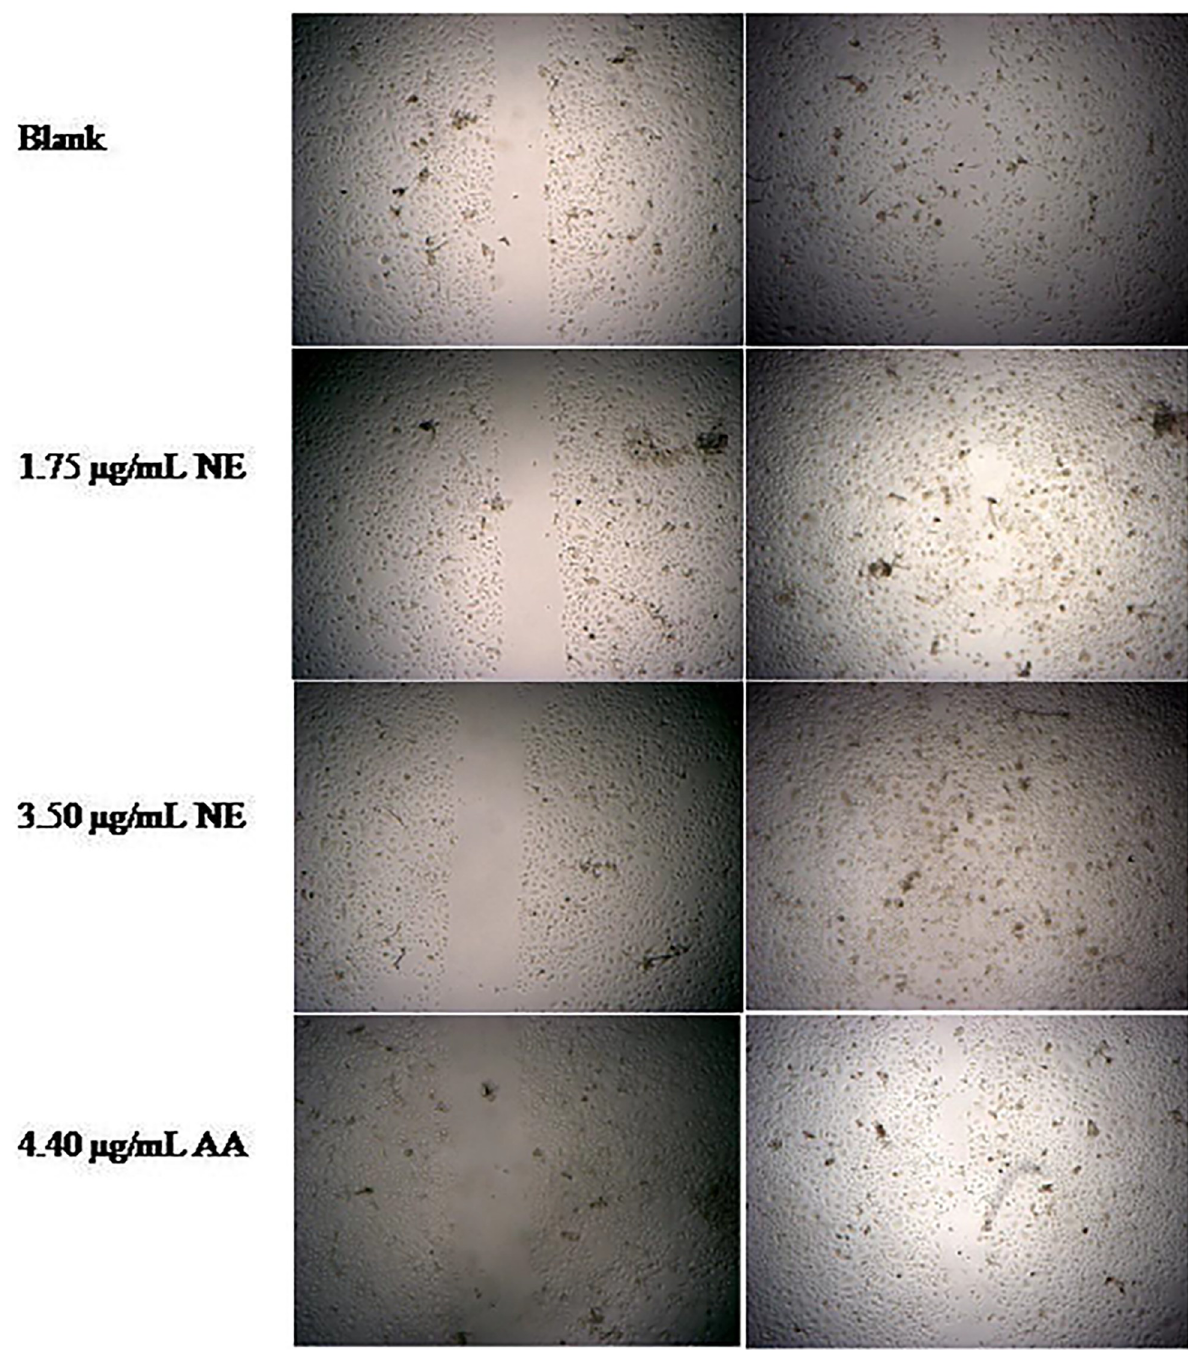
Fig 3. Keratinocytes cellular gap closure after different treatments. Notes: Blank = untreated samples; AA = Ascorbic acid; NE = Nanoemulsions. https://doi.org/10.1371/journal.pone.0267381.g003 zebrafish decreased on exposure to high nanoemulsion concentrations, while no death was found when exposed to untreated and ascorbic acid groups. The acute lethal concentration at 50% (LC value) for adult zebrafish exposed to nanoemulsion was 5 mg/mL (Fig 5). Fig 6 50 shows the prolonged toxicity test (14 day post exposure, dpe) of different treatments. Results